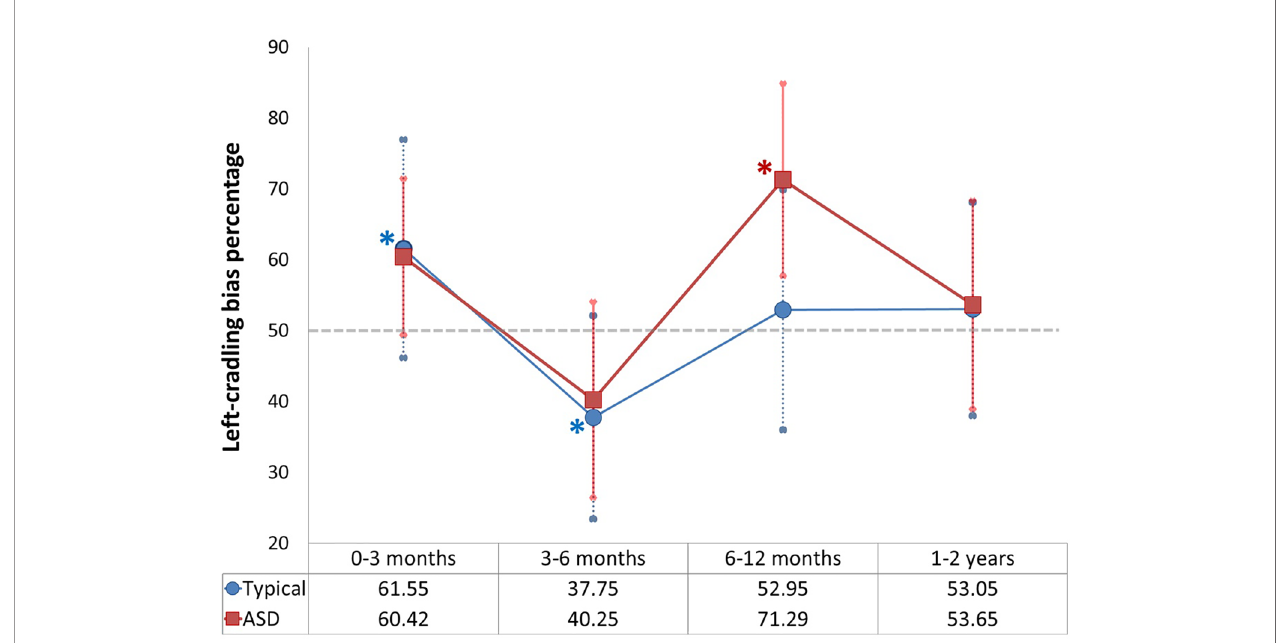
FIGURE 2 | Left-cradling percentage based on cradling laterality quotient (CLQ) of mothers of typical and Autism Spectrum Disorders (ASD) children in all age groups (the asterisks indicate signi fi cance of p < 0.05 [in blue as regards typical children; in red as regards ASD children]; the grey dashed line indicates the chance level [50%]; error bars indicate standard